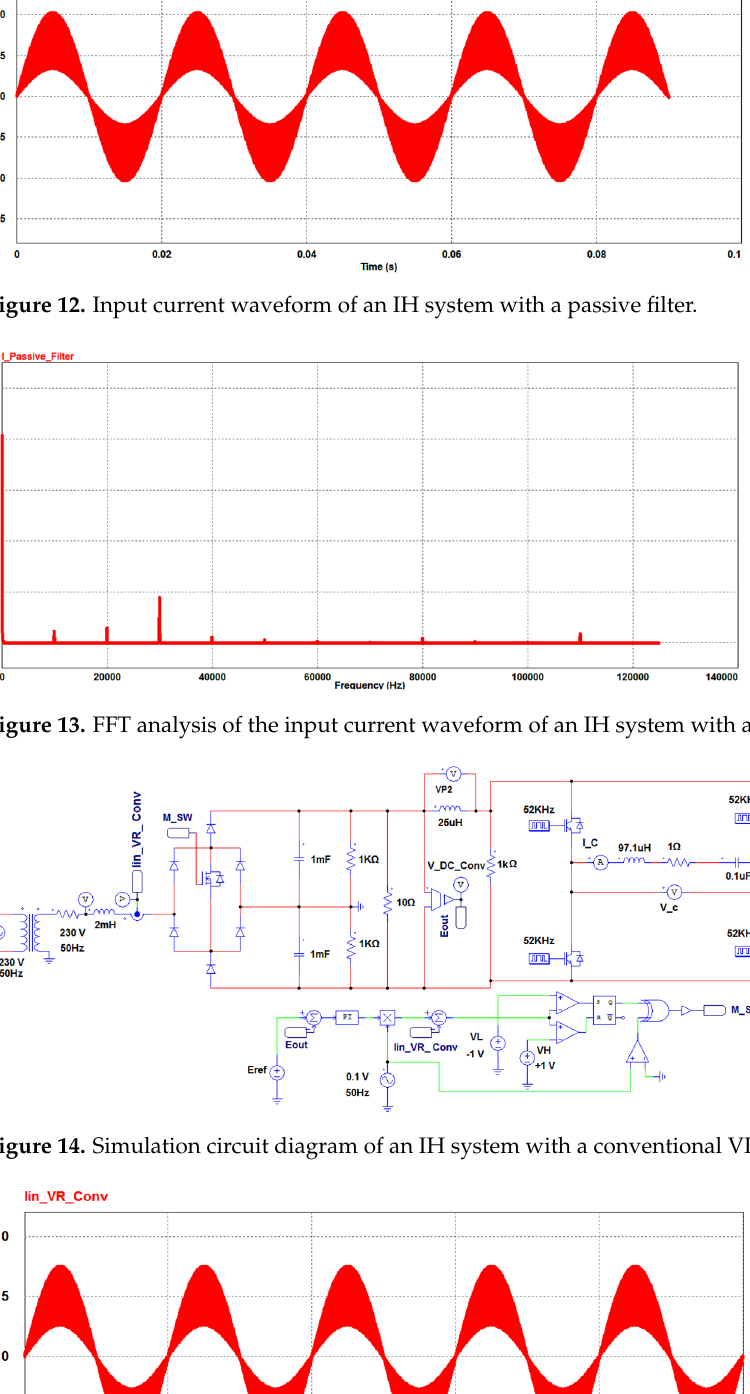
Figure 11. Simulation circuit diagram of an IH system with a passive filter.